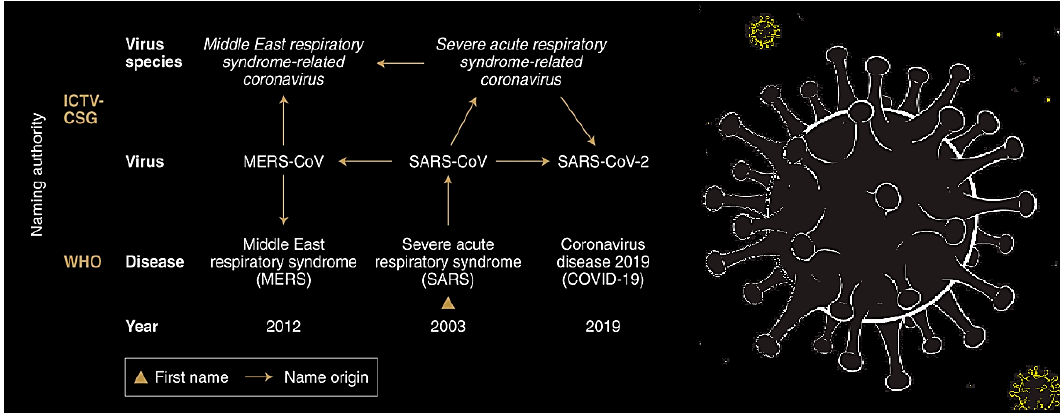
Figure 2. SARS-CoV, MERS-CoV, and SARS-CoV-2 classification. Redrawn from [12], an open access article (CC BY).